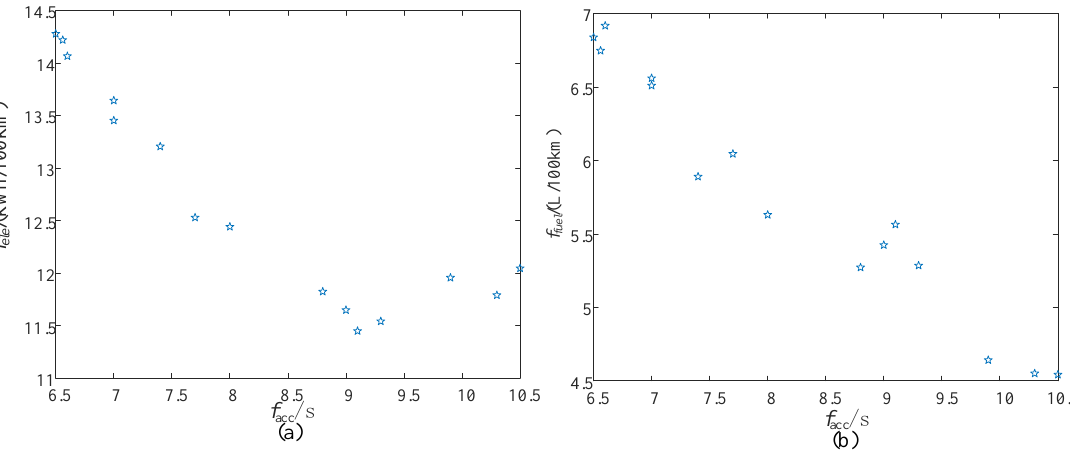
Figure 14. The Pareto optimal front using the weight approach. ( a ) The term Pareto front graph between the acceleration time and electric energy consumption and ( b ) the term Pareto front graph between the acceleration time and fuel economy.